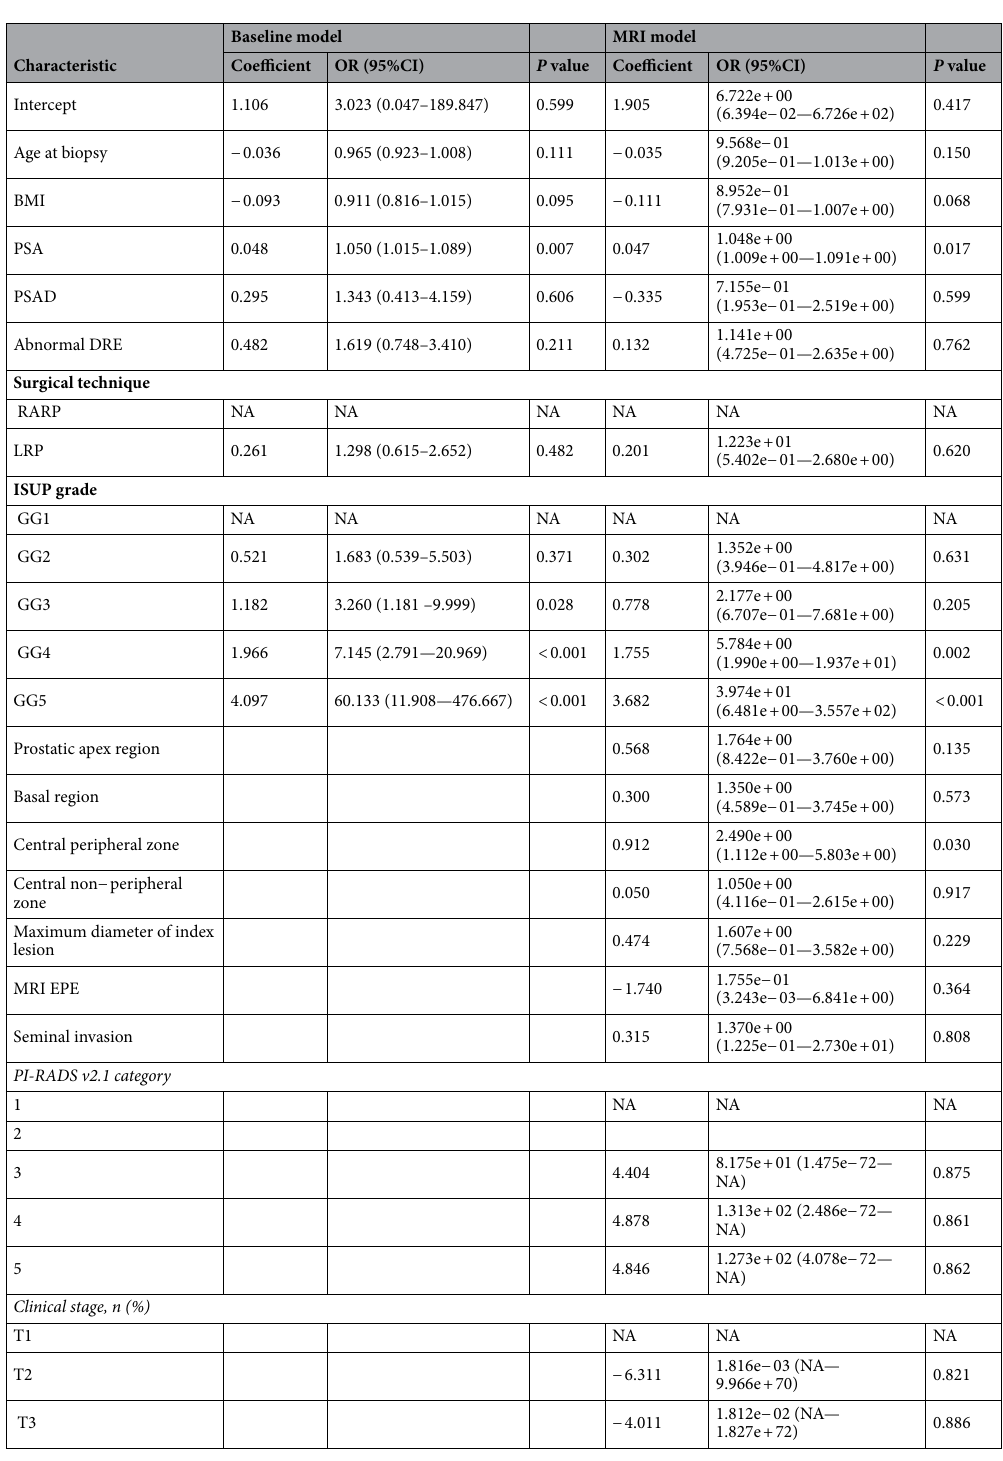
Table 3. Logistic Regression Prediction Models of Biochemical Failure for Research Cohort. DRE Digital Rectal Examination; IQR Interquartile Range; PI-RADSv2 Prostate Imaging-Reporting and Data System version 2; PSA prostate-specific antigen; PSAD PSA density; ISUP International Society of Urological Pathology; GG Grading Group; RARP Robot-Assisted Radical Prostatectomy ; LRP Laparoscopic Radical